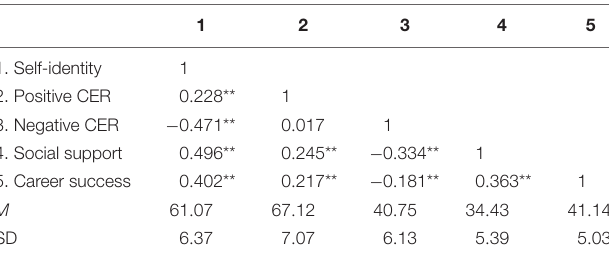
TABLE 1 | Means, SD, and